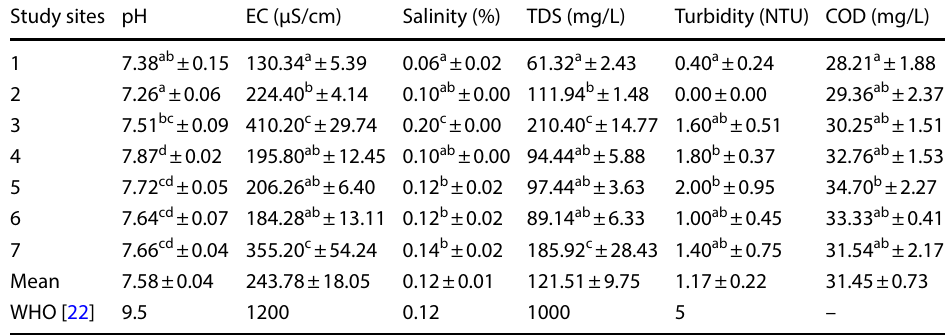
Table 3 Physico-chemical properties of Indus River water from cold desert high- altitude trans-Himalayan